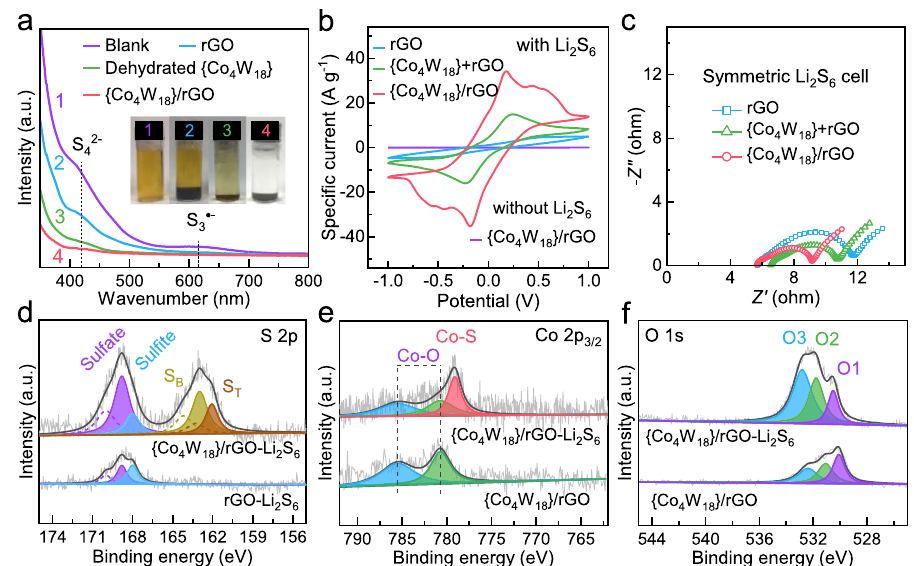
Fig. 2 Adsorption and conversion reactions of polysul fi des. a UV – vis adsorption spectra of Li 2 S 6 solution before and after adsorption by various materials for 3 h (inset fi gure: optical images of the above solutions). b CV curves and c Nyquist plots of Li 2 S 6 symmetrical cells with the rGO, {Co 4 W 18 } + rGO, and {Co 4 W 18 }/rGO electrodes. XPS pro fi les of d S 2p, e Co 2p, and f O 1 s peaks for rGO and {Co 4 W 18 }/rGO before and after adsorption of polysul fi